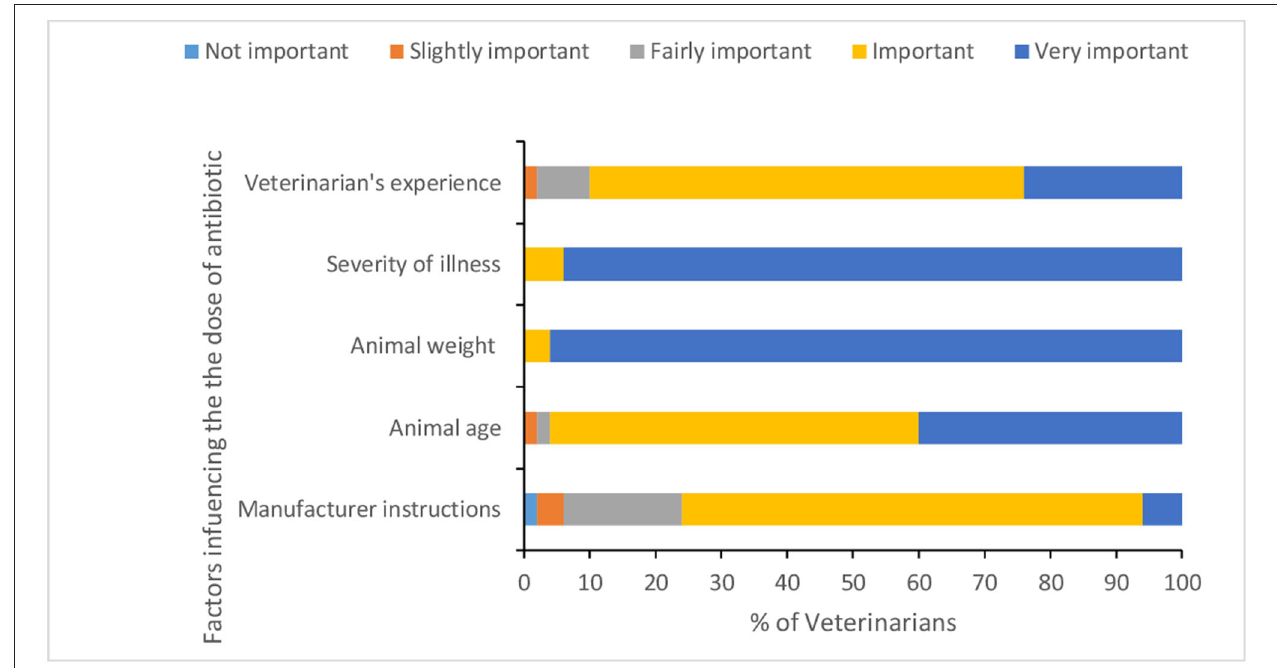
FIGURE 4 | Factors influencing veterinarians’ decisions for antibiotic dose.